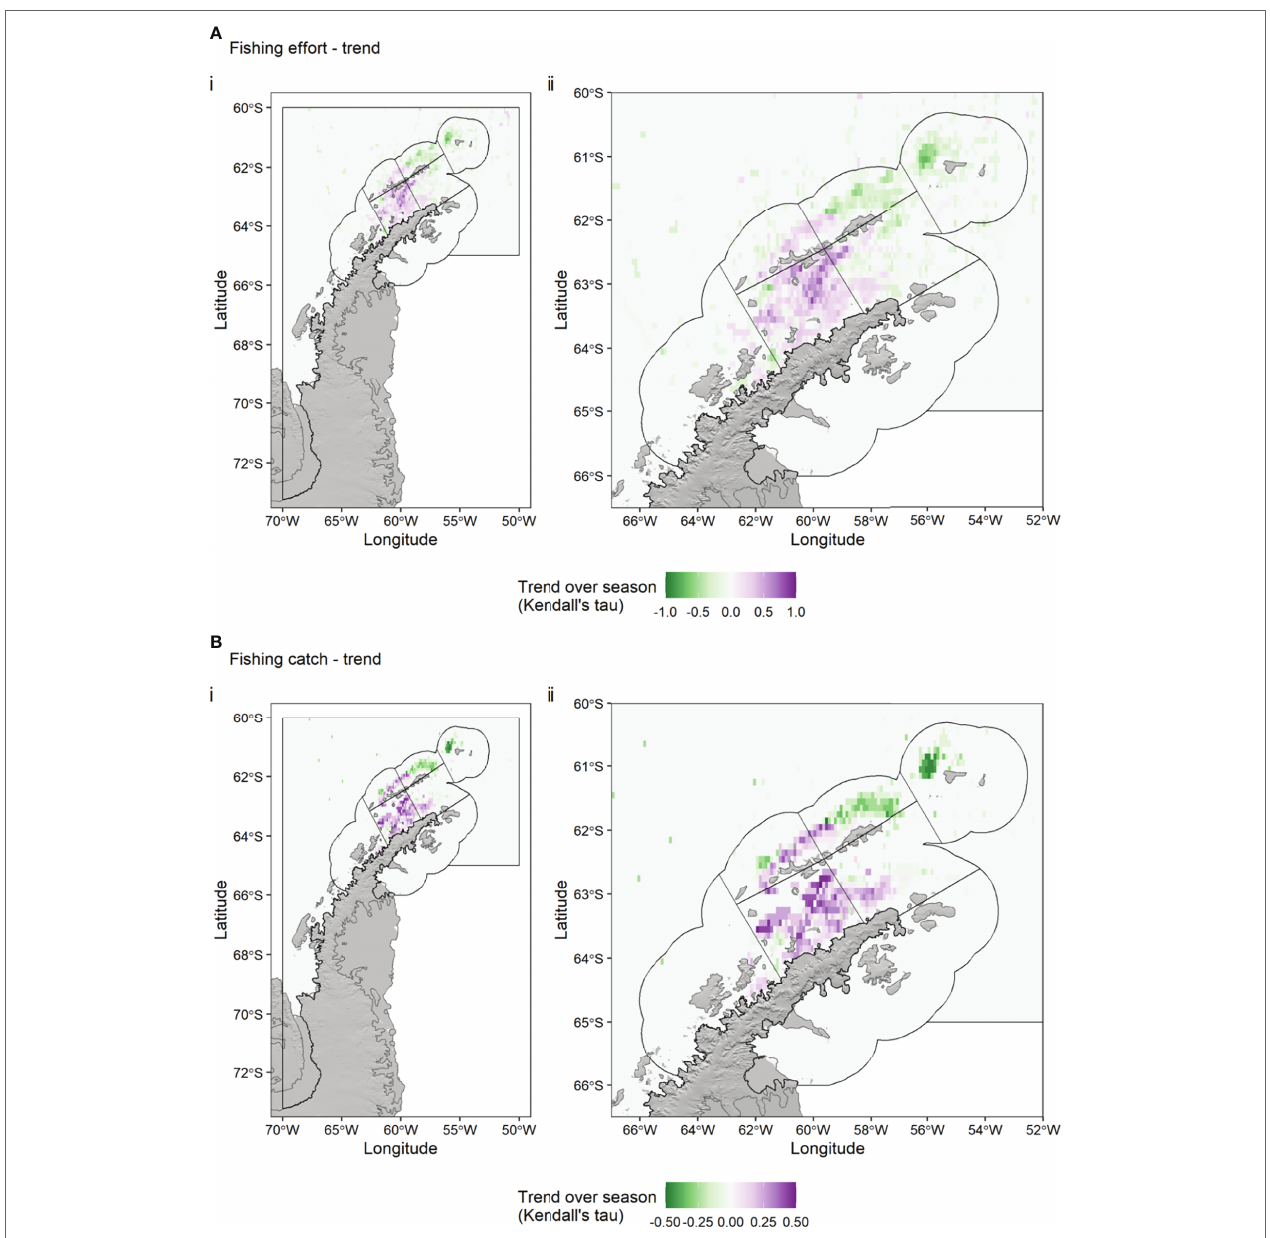
FIGURE 6 | Trend (Kendall’s tau) in Antarctic krill fishing effort (A) and catch (B) over all fishing seasons (December – July), 2015-2020, depicting the average movement of the fishing effort (top) and catch (bottom) within seasons. Green colours indicate a decrease in effort (top) or catch (bottom) in a given 0.1° x 0.1° grid cell over the season, while purple colours indicate an increase. Black polygons indicate the seven Small Scale Management Units (SSMUs) within the Subarea. Effort data: Global Fishing Watch. Catch data: